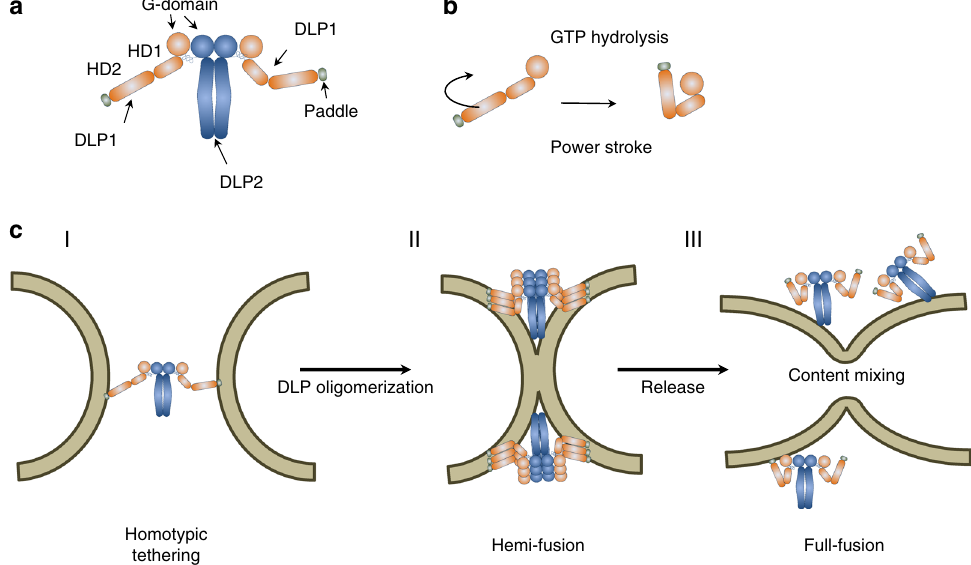
Fig. 1 Function of bacterial DLPs in membrane fusion. a Cartoon of the C. jejuni DLP1/DLP2 hetero-oligomer. DLP2 (blue) forms a central dimer fl anked on either site by a subunit of DLP1 (orange). The connection of DLP1 and DLP2 is mediated by a short helix and membrane binding of DLP1 is mediated by a paddle domain at the end of HD2 (olive). b Based on structures of BDLP from N. punctiforme , domain rotation driven by a GTP-hydrolysis cycle is assumed to be the power stroke for membrane deformation or tethering. c Simpli fi ed model of bacterial DLP like membrane fusion. (I) A DLP hetero-oligomer tethers homotypic membranes in trans. (II) Conformational rearrangements are the power stroke to bring membrane in close proximity. Thereby, the membrane is likely bend and a hemi-fusion stalk is generated. The rim of this hemi-fusion stalk is occupied by DLP polymers. (III) Release of the DLP may lead to a sudden relaxation of the highly bend membrane and trigger full fusion leading to content